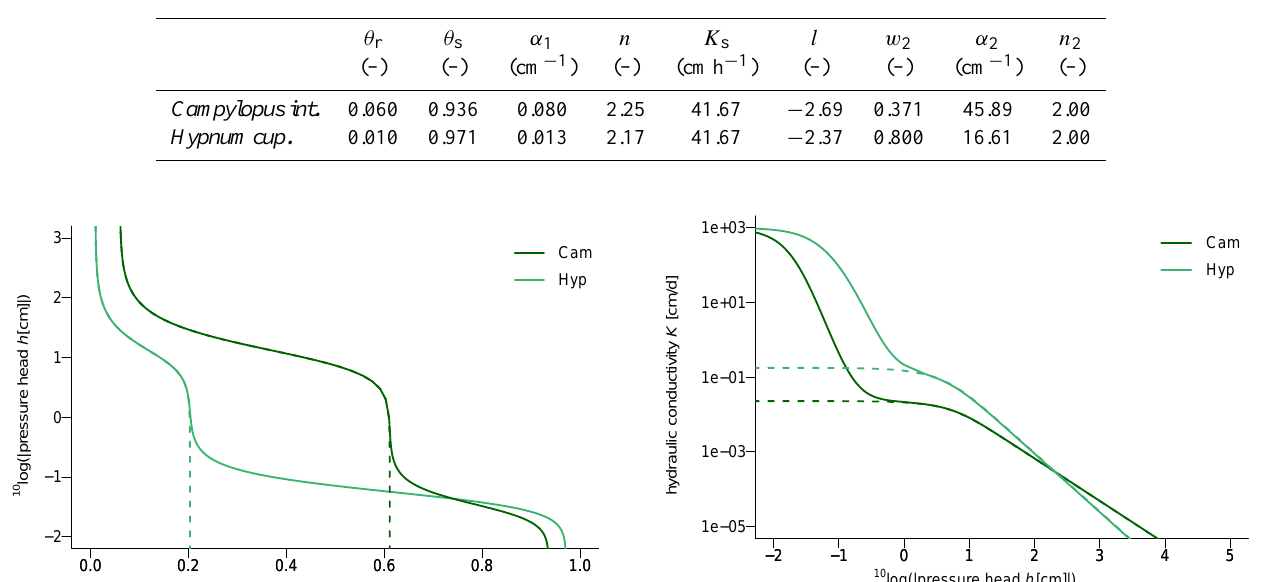
Table A2. Hydraulic parameter values of the two moss species.